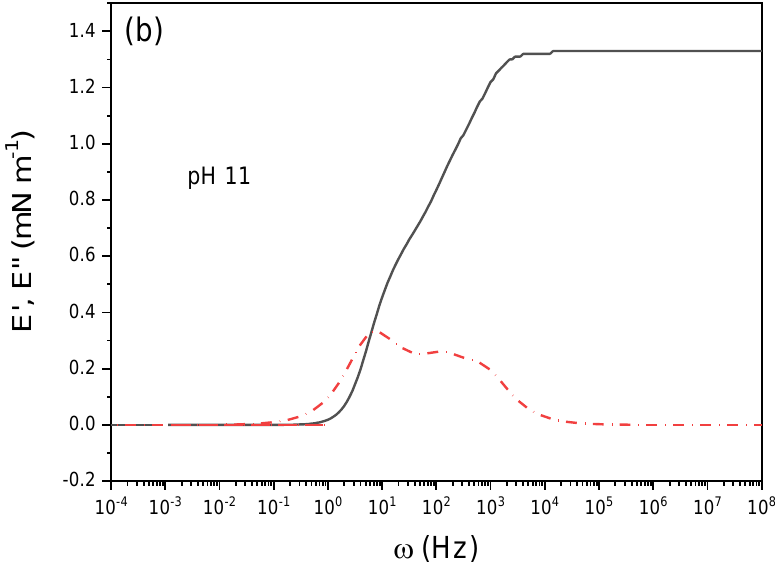
Figure 7. Storage, E′, and loss. E″, moduli of dilations surface rheology experiments for 1 mg mL −1 PAA + 0.1 mM G12 mixtures in aqueous solution. ( a ) pH 6; ( b ) pH 11. PAA + 0.1 mM G12 mixtures in aqueous solution. ( a ) pH 6; ( b ) pH